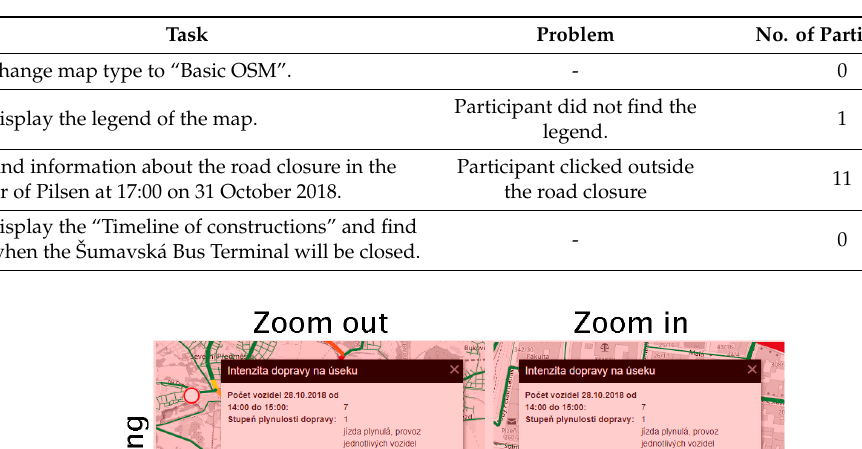
Table 3. Problems identified with the Pilsen map.